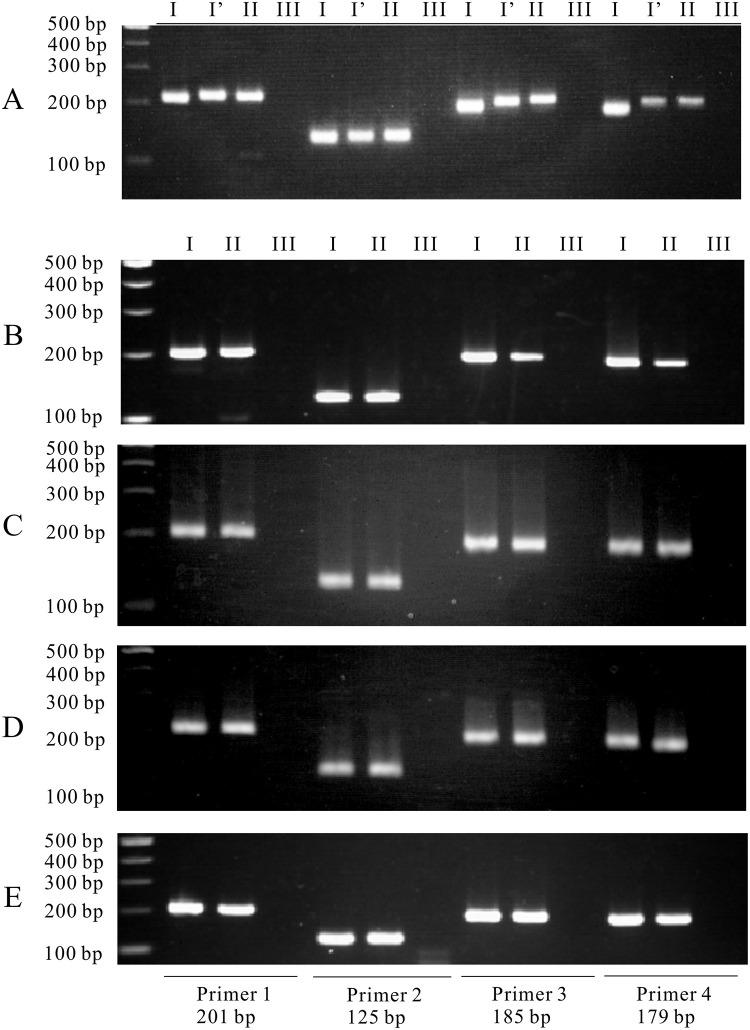
RT-PCR electrophoresis of five SFTS cat cases.The PCR product bands were observed. I and I’: sample RNA, II: positive control, III: negative control. (A) No. 1, (B) No. 2, (C) No. 3, (D) No. 4, and (E) No. 5.